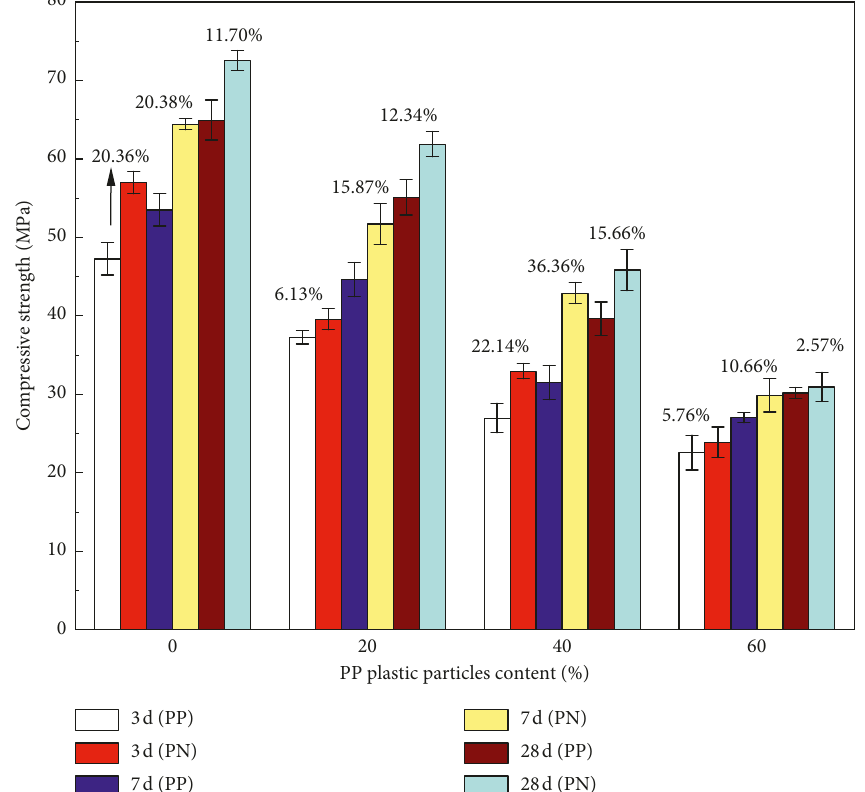
Figure 5: Evolution of the compressive strength of mortars as function of curing time (3, 7, and 28d). The error bars represent the standard deviation of six test